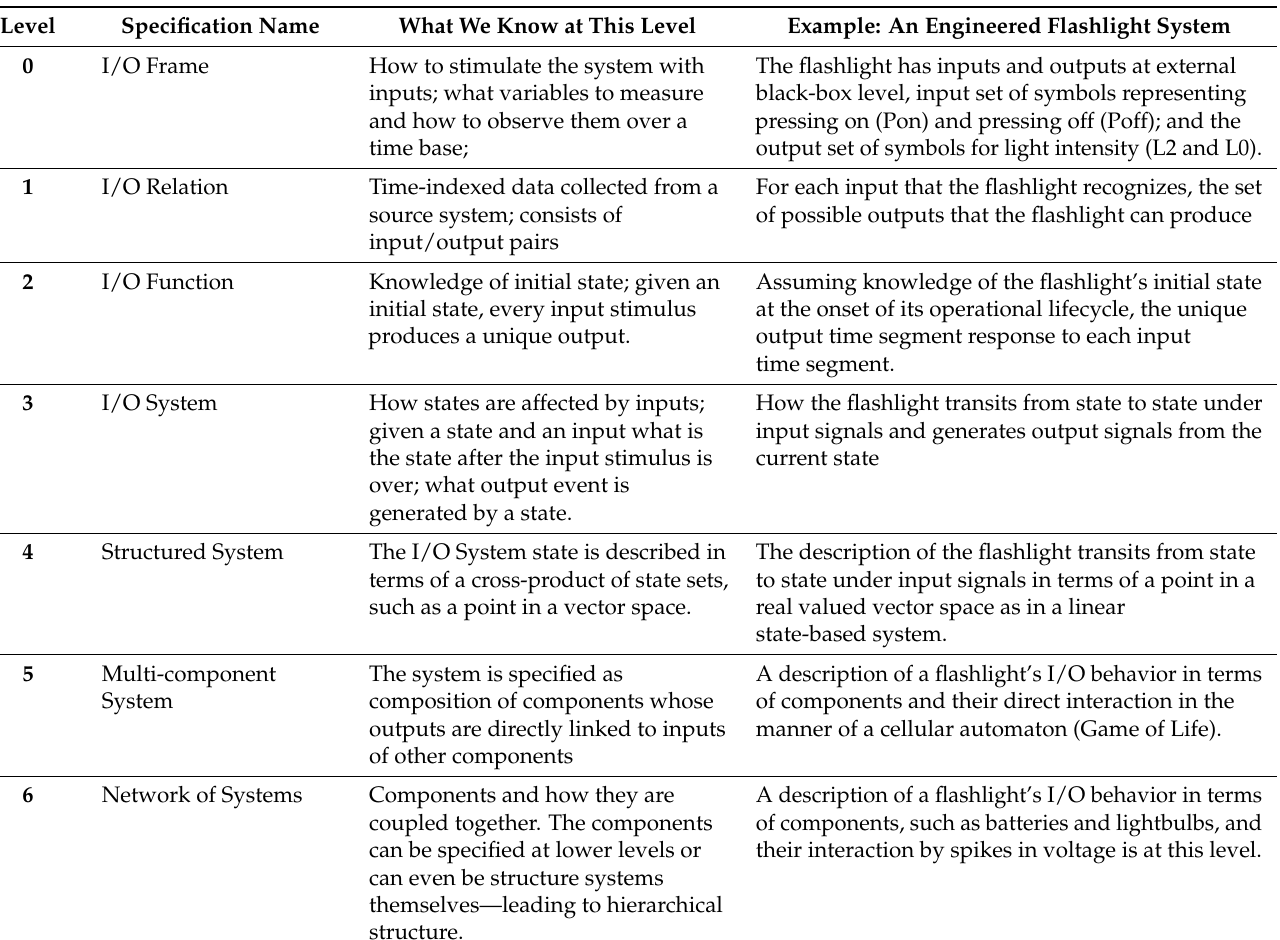
Table 1. Informal Description of the Levels of System